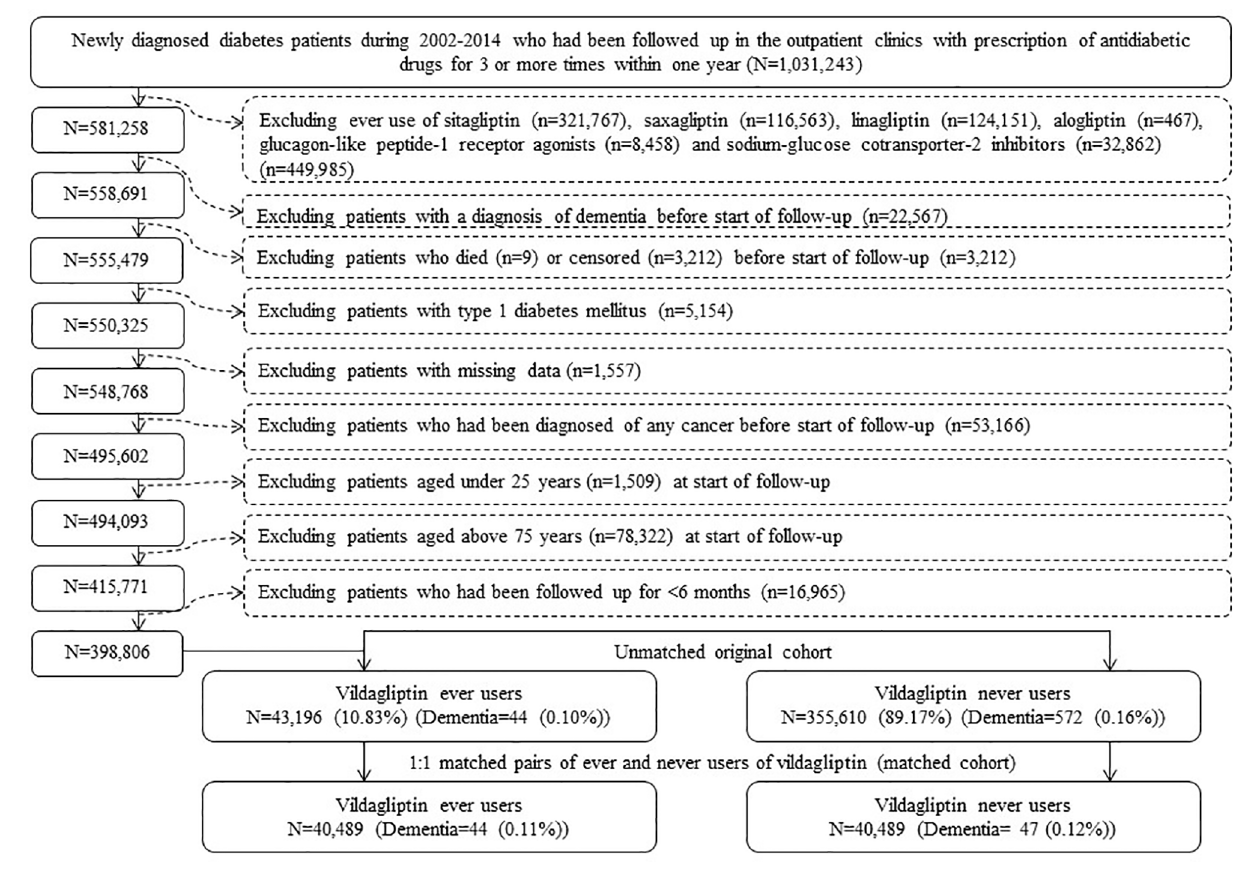
FIGURE 1 | Flowchart showing the procedures followed in creating the unmatched original cohort and a cohort of 1:1 matched pairs of ever users and never users of vildagliptin from the reimbursement database of the National Health